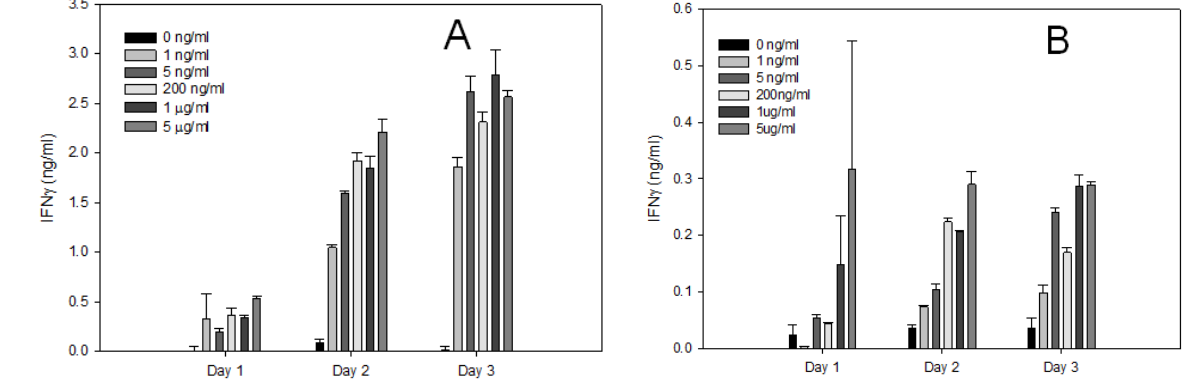
Figure 3. Quantification of biologically active SEA using ELISA assay. Increasing concentrations of SEA was incubated with splenocytes ( A ) or CD4 + T-cells ( B ). After 24, 48 or 72 h of stimulation with SEA, IFN-γ protein secretion was measured by ELISA assay . Error bars represent standard